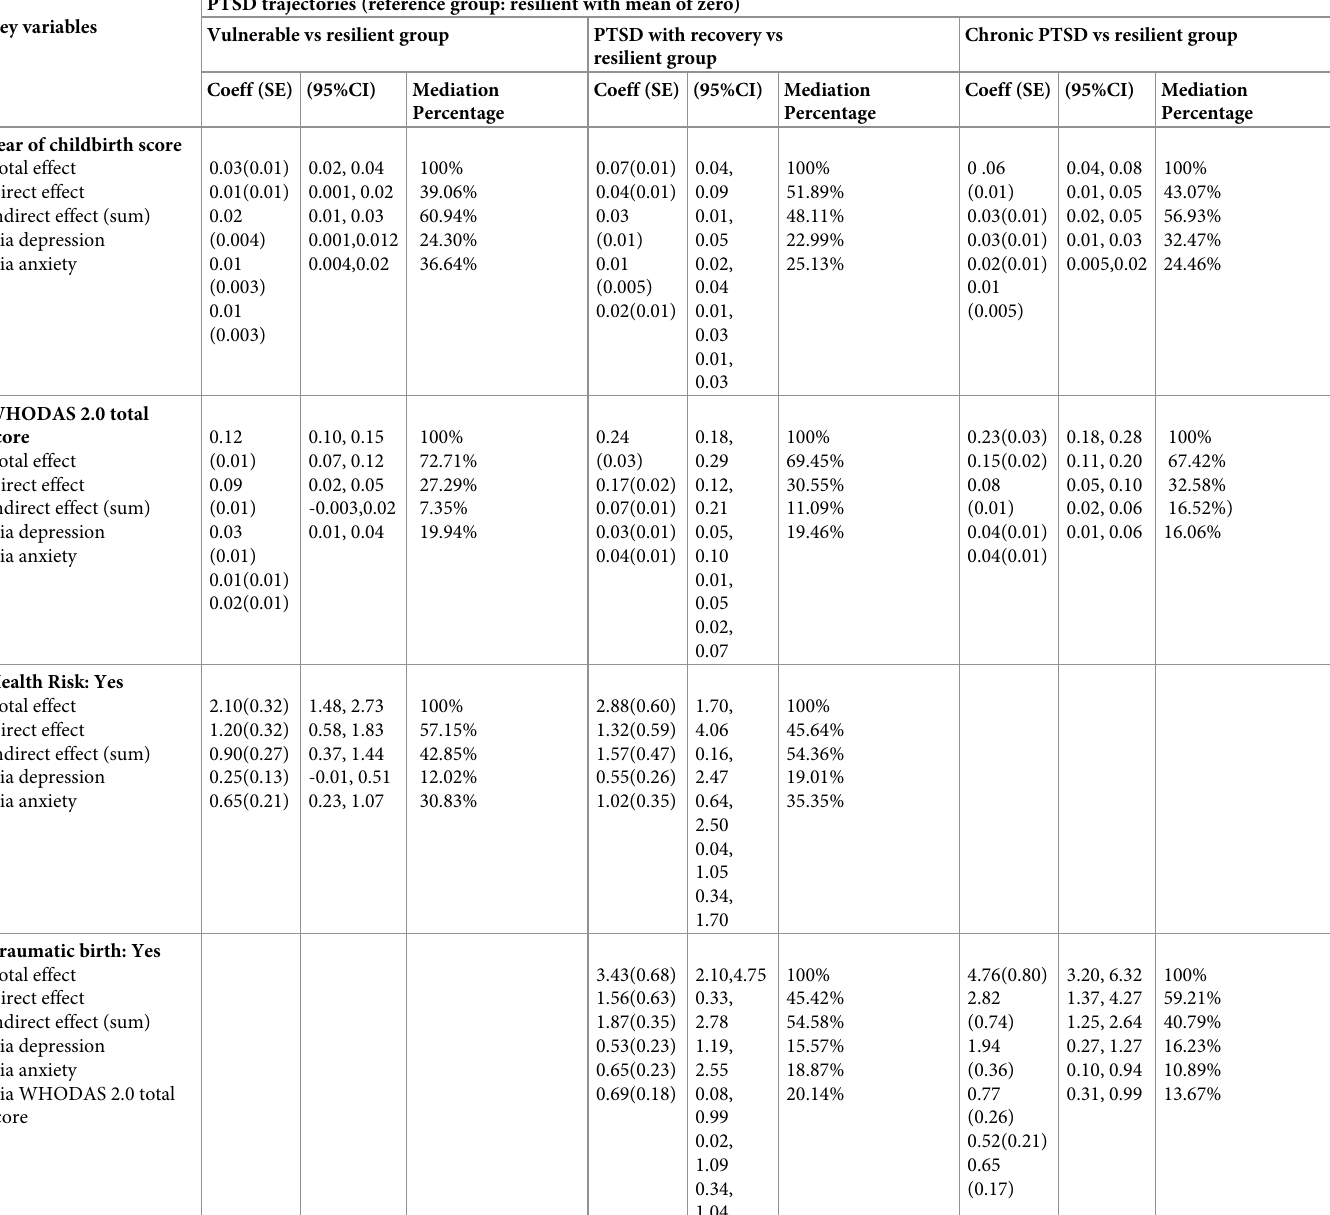
Table 5. Decomposition of the Total Effect of statistically significant key independent variables on PTSD trajectories into Direct and Indirect Effects using the KHB method among postpartum women, Northwest Ethiopia, 2021. Key